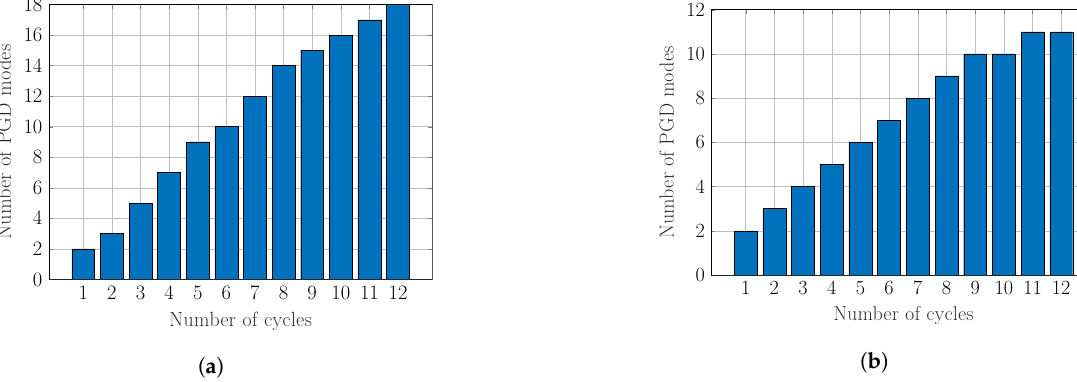
Figure 5. Number of PGD modes in each cycle using different orthonormalisation schemes. ( a ) number of PGD modes using GS; ( b ) number of PGD modes using